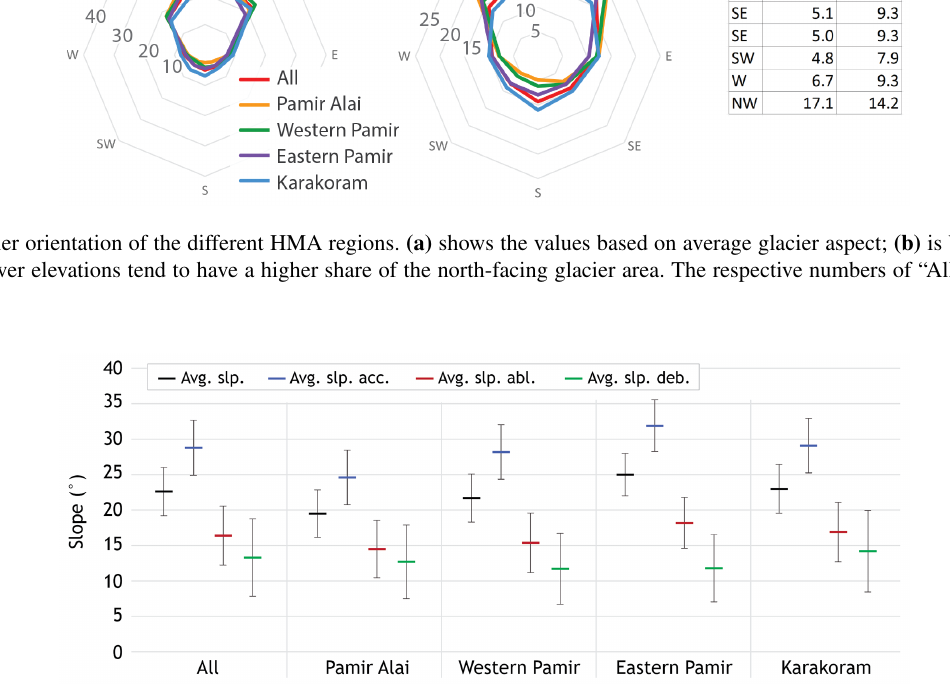
Figure 9. Slope per glacier regions and surface type (avg. slp.: average slope of glacierized area; avg. slp. acc.: average slope in the accumulation area; avg. slp. abl.: average slope in the ablation area; avg. slp. deb.: average slope in the debris-covered